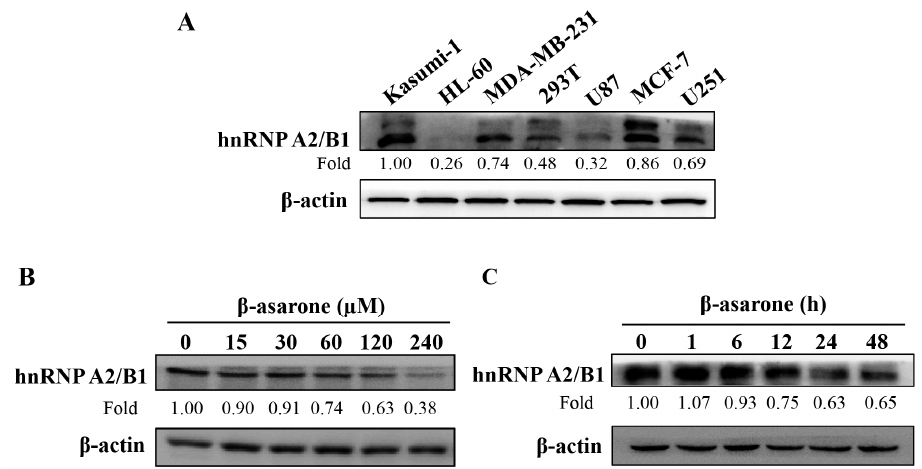
Figure 4. Analysis of hnRNP A2/B1 protein expression. ( A ) Detection of hnRNP A2/B1 protein expression in various cell lines. The cell lines as indicated were seeded and cultured for 24 h; ( B , C ) Effect of β -asarone on the expression of hnRNP A2/B1 in U251 cells. Cells were treated with β -asarone with different concentrations for 24 h or with 60 μ M β -asarone for different times, as indicated. The expression of hnRNP A2/B1 was determined by Western blotting. The blots were representative of three independent experiments.